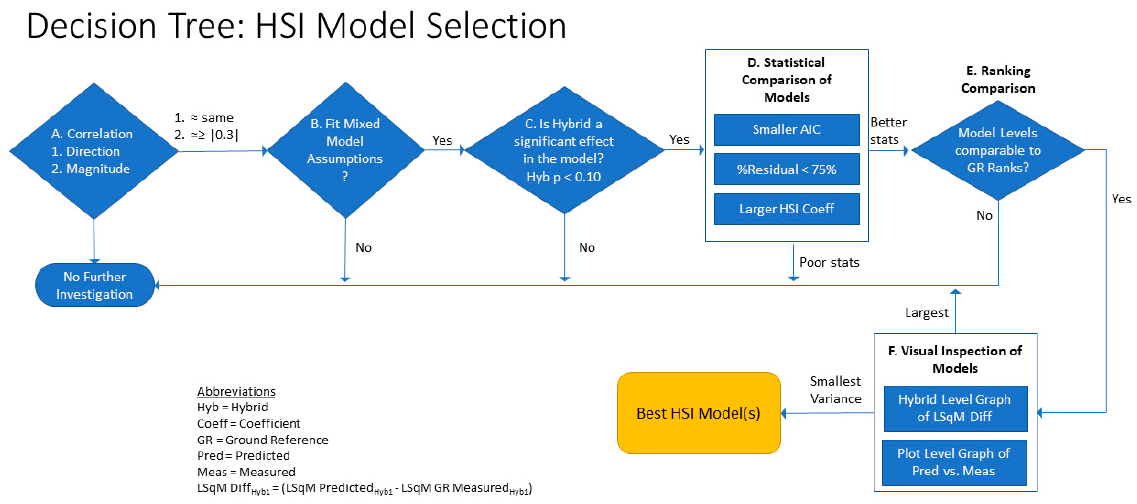
Figure 1. Decision tree used for selecting the best HSI models.